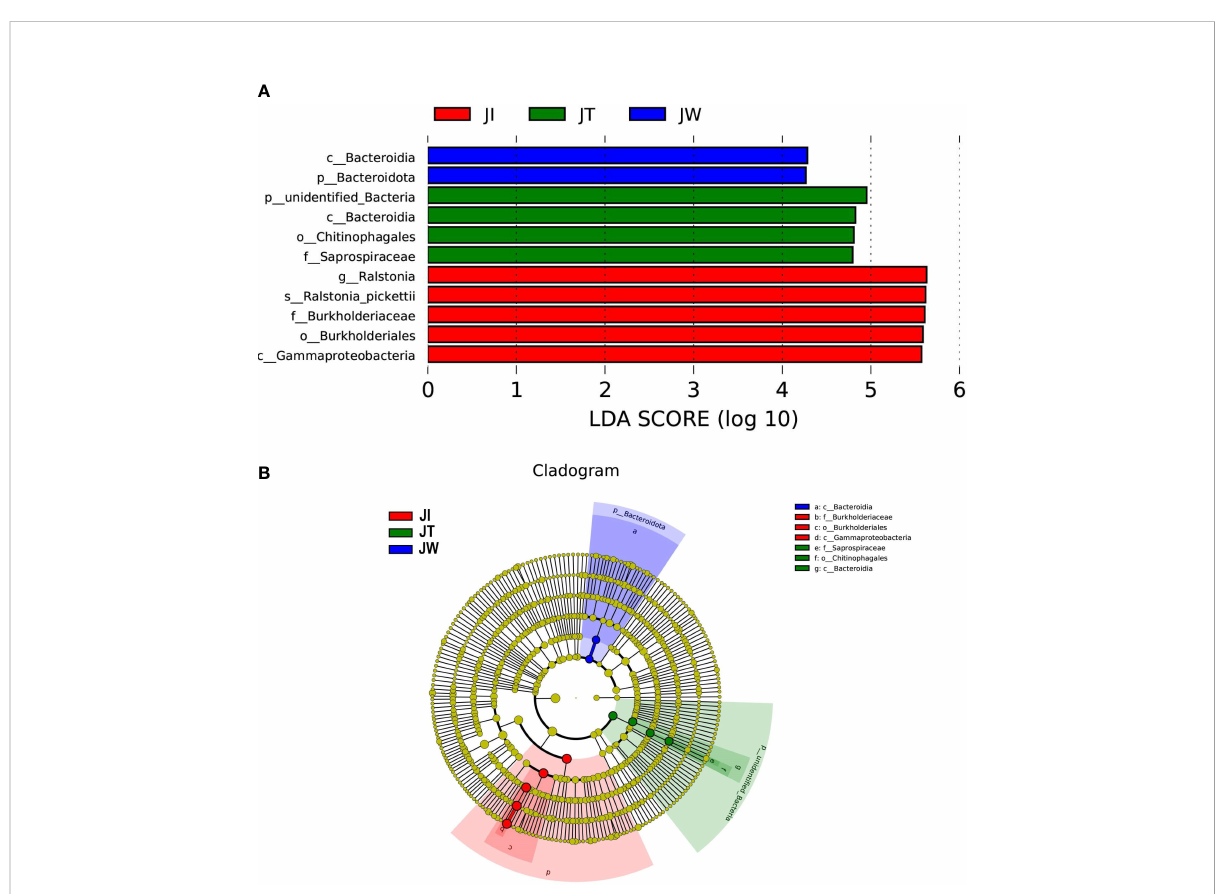
FIGURE 6 LEfSe analysis of JI, JW, and JT. (A) Only taxa with LDA values (in fl uence value of linear discriminant analysis) higher than four are shown. (B) Evolutionary branch graph of differential bacterial communities or